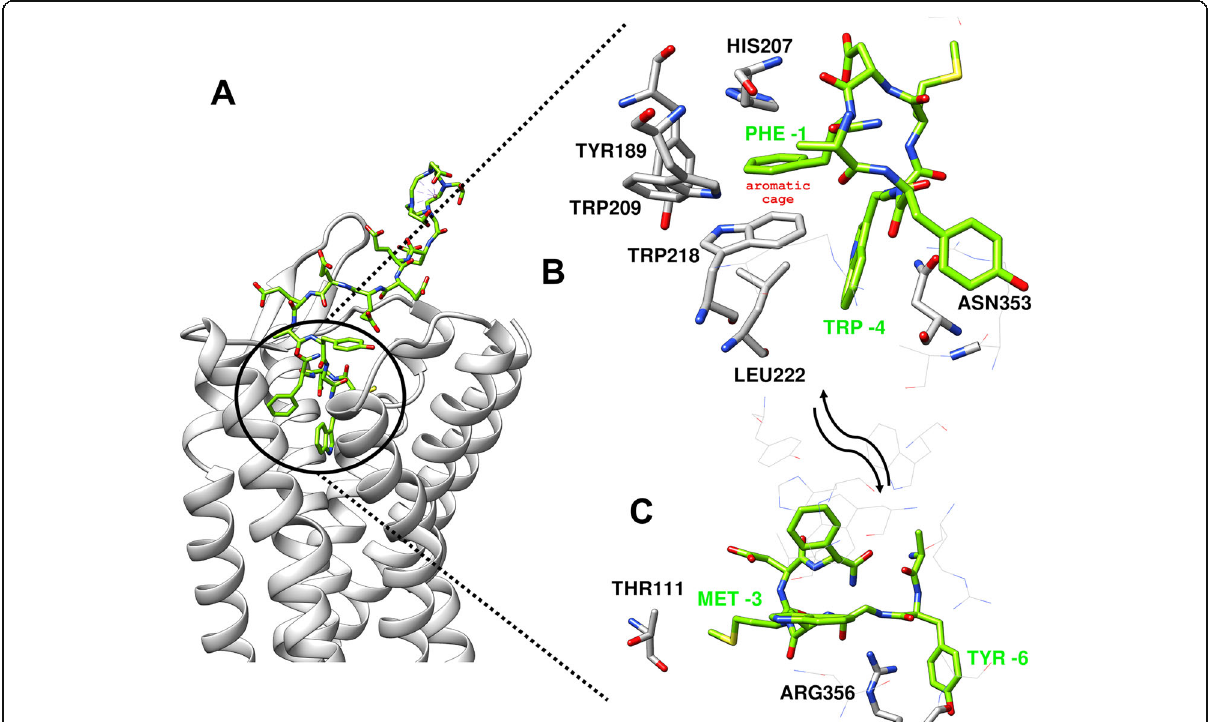
Fig. 3 CP04 (green) docked to the homology model of the CCK2 receptor (gray): ( a ) general view and ( b , c ) focus on the interactions of the four C-terminal residues with the receptor presented from two perspectives